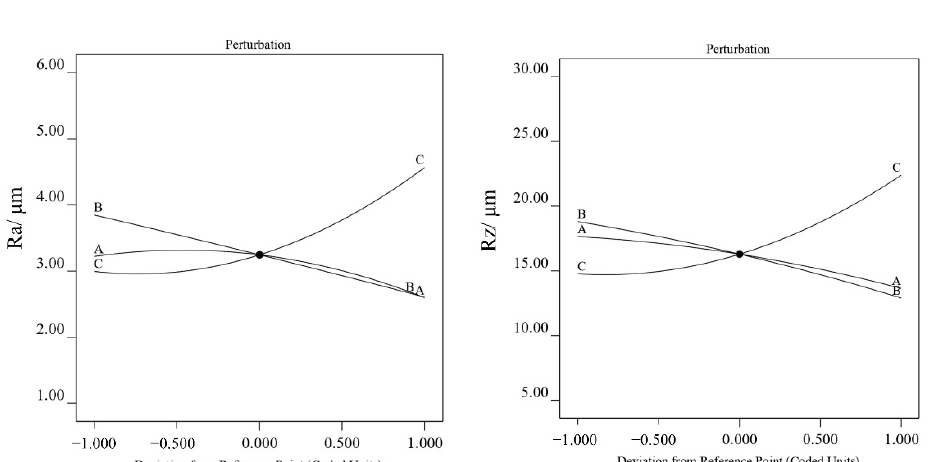
Figure 1. Influence trend chart for different input variables. It is obvious that the input parameters had significant effects on Ra and Rz; moreo- ver, with the increase in the helical angle and rotation speed of the main shaft, the for- mation of a higher quality surface took place; that is, the values of Ra and Rz decreased. However, the parameters of Ra and Rz increased with the increase in milling depth. The probable reason for this is that the milling width increases more gently with the increase in the helical angle of the milling cutter, which induces the milling process smoother. This result has a good agreement with the LVTs’ materials helical milling process [14]. When the rotation speed of main shaft increases and milling depth decreases, the quanti- ty removed per tooth during Scots pine wood milling process decreases, and less re- sistance acts on the knife edge, thus reducing the milling vibration and resulting in a smoother machined surface [13]. Apart from the main parameters, the interactions between input parameters also have influences on the response factors. The interacting effects of the helical angle and main shaft rotation speed ( λ × n ) and helical angle and depth of milling ( λ × h ) were also analyzed. Figure 2 presents how the λ × n and λ × h are related to Ra and Rz. It indicates that the values of Ra and Rz decreased with an increase in helical angle and main shaft rotation speed. Moreover, the combination of increased helical angle and decreased mill- ing depth induced a decrease in the surface roughness. Hence, it is concluded that the Ra and Rz can be minimized with a higher helical angle, higher rotation speed, and lower depth of milling combinations. Moreover, Figures 3 and 4 indicate that the minimum Ra and Rz could be achieved by the highest helical angle, the highest rotation speed, and the lowest depth of milling combination.